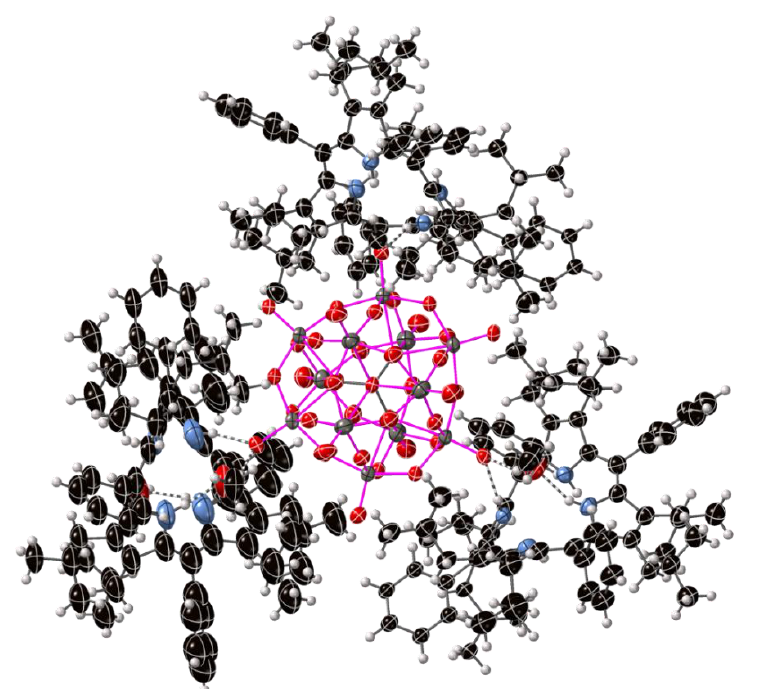
Figure 6. The 6,3-net structure of a single layer of the porphyrin – POM hybrid material [H 4 2 ] 3 (Mo VI12 O 36 (PO 4 )) 2 ·60(CH 3 OH)·1.5(H 2 O). The POM components are shown in pink bonds, while atoms are represented as spheres of a fixed radius.